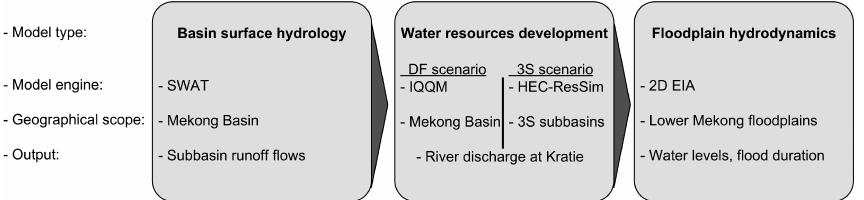
Figure 2. Models used and their general features. DF is definite